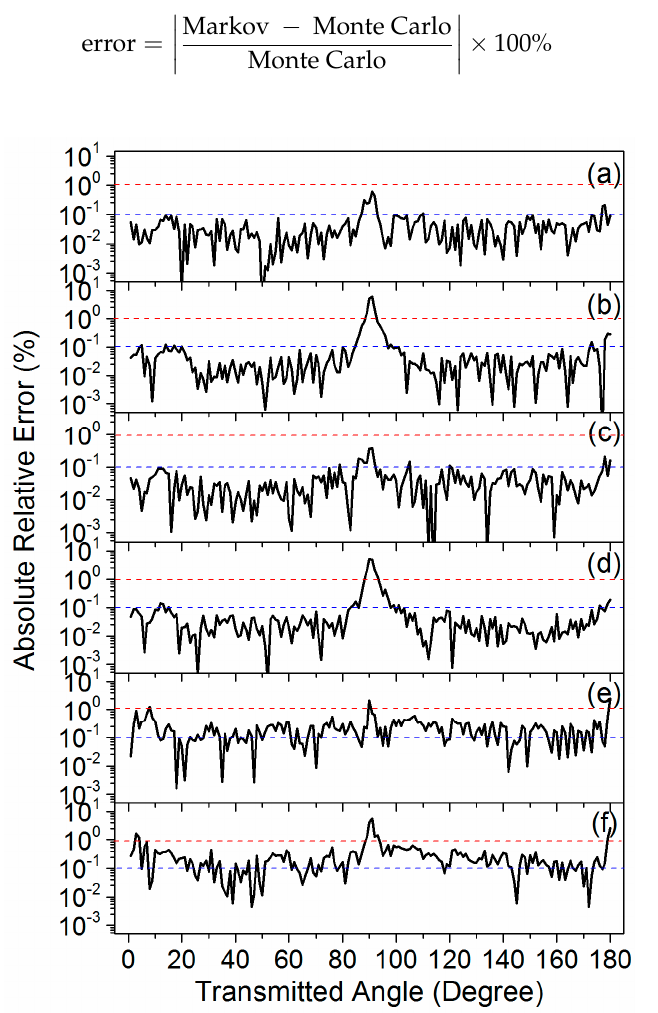
Figure 4. Absolute relative error of Markov chain angular distribution predictions compared to Monte Carlo simulations. Panel ( a ). Phase function 1, OD = 2; Panel ( b ). Phase function 1, OD = 5; Panel ( c ). Phase function 2, OD = 2; Panel ( d ). Phase function 2, OD = 5; Panel ( e ). Phase function 3, OD = 2; Panel ( f ). Phase function 3, OD = 5. Red dash lines indicate an error threshold of 1.0%, and blue dash lines indicate a threshold of